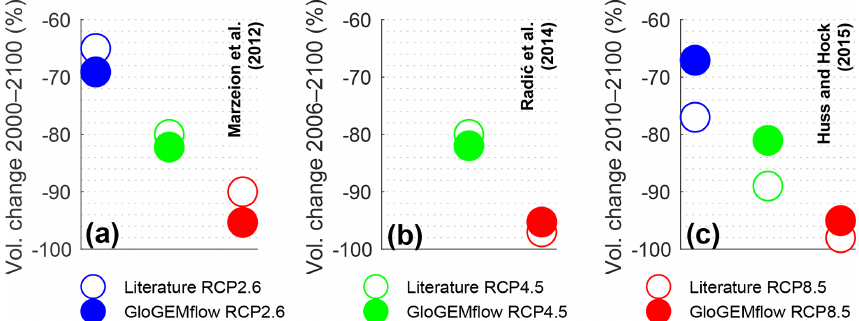
Figure 14. Modelled volume changes and comparison with values from the literature (Marzeion et al., 2012; Radi´c et al., 2014; Huss and Hock, 2015). The considered time period is in line with the considered study and spans from the early 21st century to 2100.